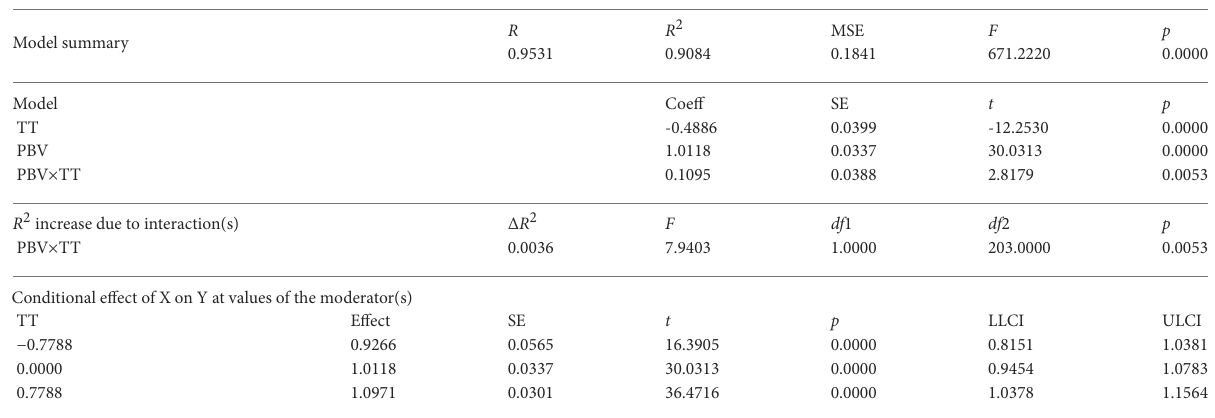
TABLE 6 Theresultsfromtestingthemoderatingeffectsoftechnologicalturbulence.